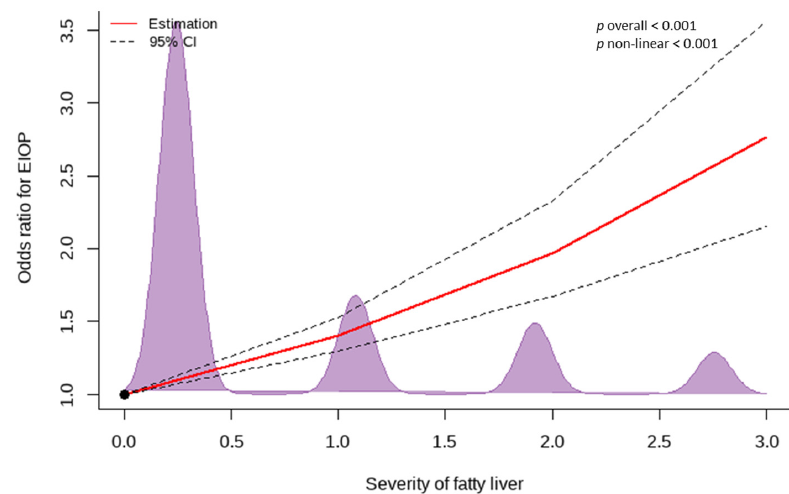
Figure 3. Dose–response relationship between odds ratio for EIOP and the severity of fatty liver shown as a restricted cubic spline curve. The red line indicates an estimated odds ratio. The dotted lines indicate 95% confidence intervals. The purple area indicates the density of the population. Abbreviations: EIOP, elevated intraocular pressure; CI, confidence interval. p < 0.05 was considered statistically significant.